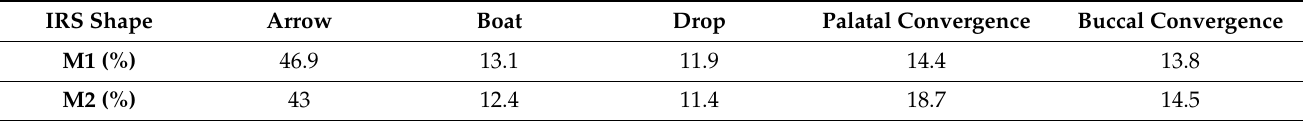
Table 2. The incidence of maxillary molars’ IRS shapes in the first (M1) and the second (M2) maxillary